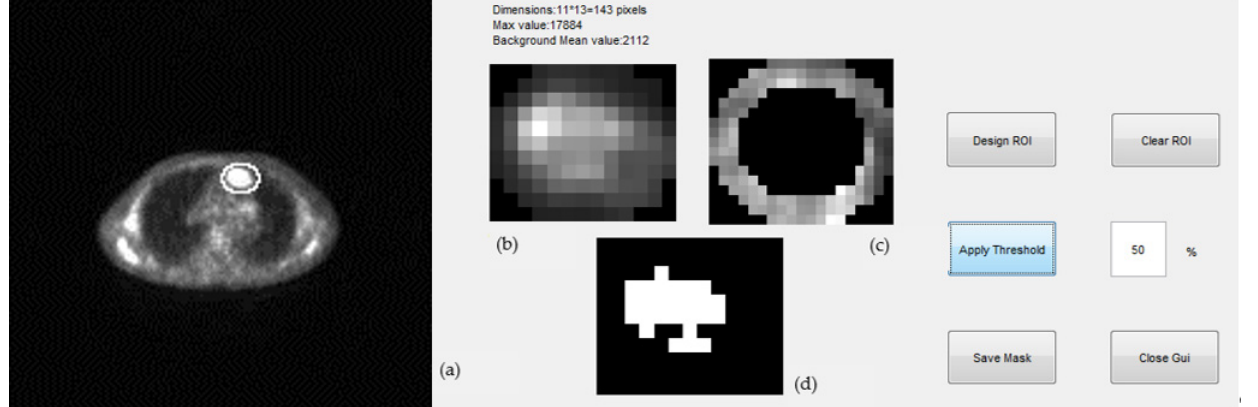
Figure 5. Representative segmentation of a mass from a PET slice where maximum diameter and area is measured using an in-house developed interface. ( a ) An ellipse was drawn around the tumor by an expert. ( b ) Area within the ellipse was shown in magnification to the expert for review. ( c ) 3-pixel ring was defined on the elliptical border for the calculation of the background intensity. ( d ) Final tumor ROI segmentation by the algorithm at a given threshold.